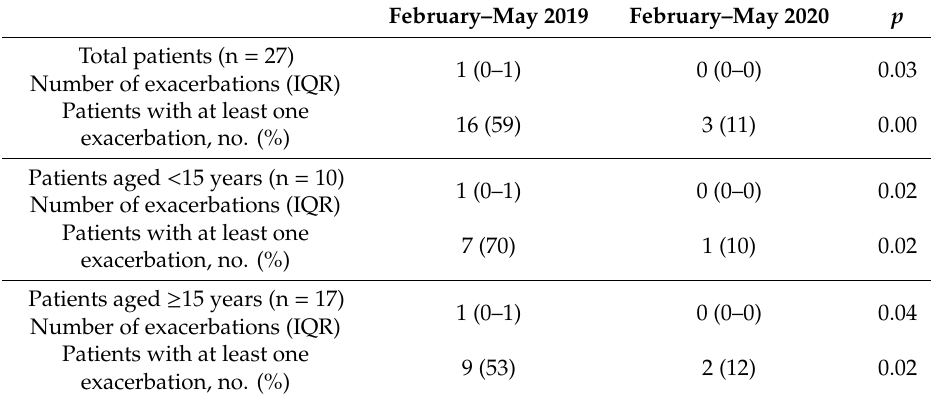
Table 4. Pulmonary exacerbations in PCD patients during COVID-19 outbreak compared to the same period of